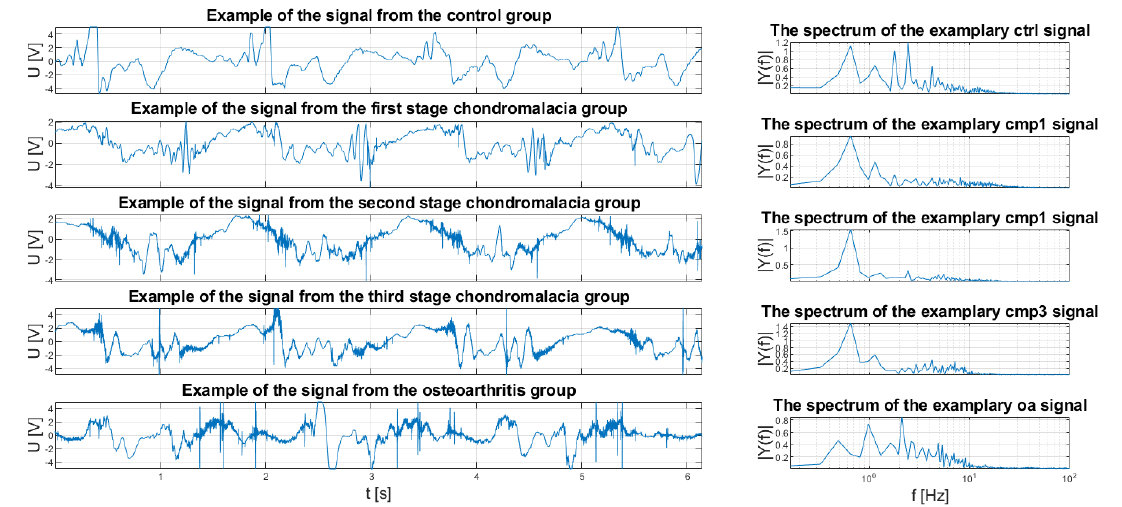
Figure 1. Exemplary signals from each condition group. The differences between signals results from the differences in condition of articular surfaces of the synovial joints.